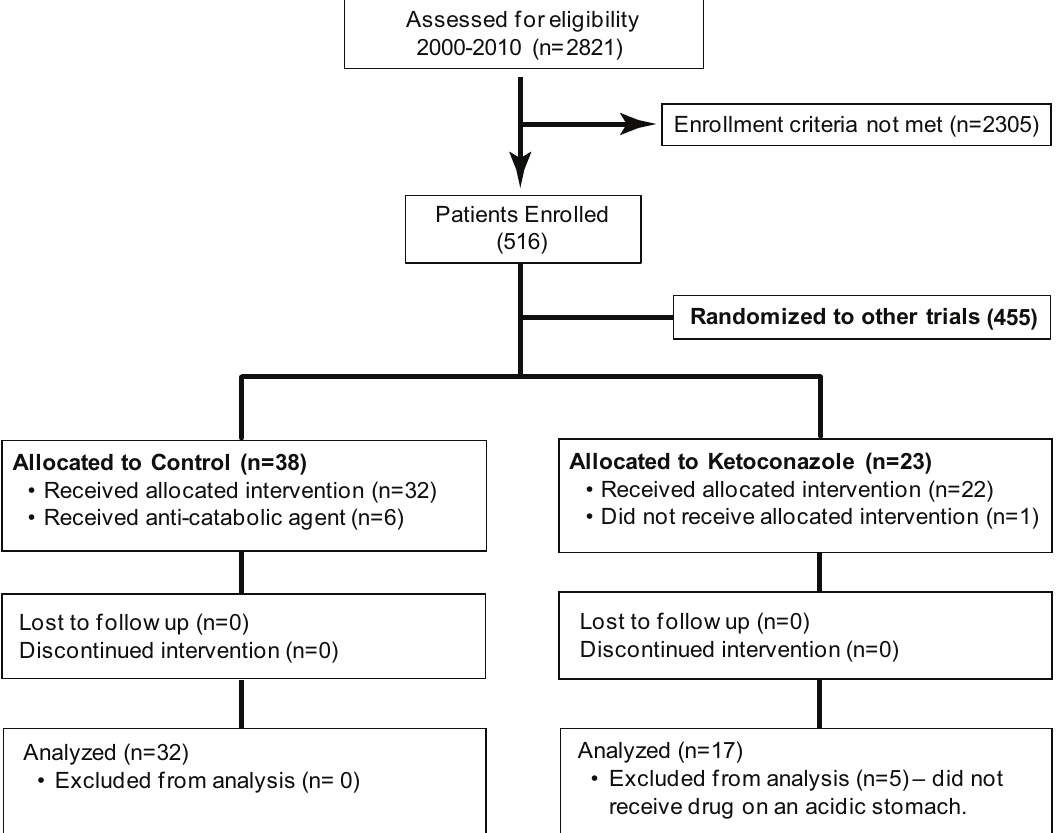
Figure 1. Consort Diagram.